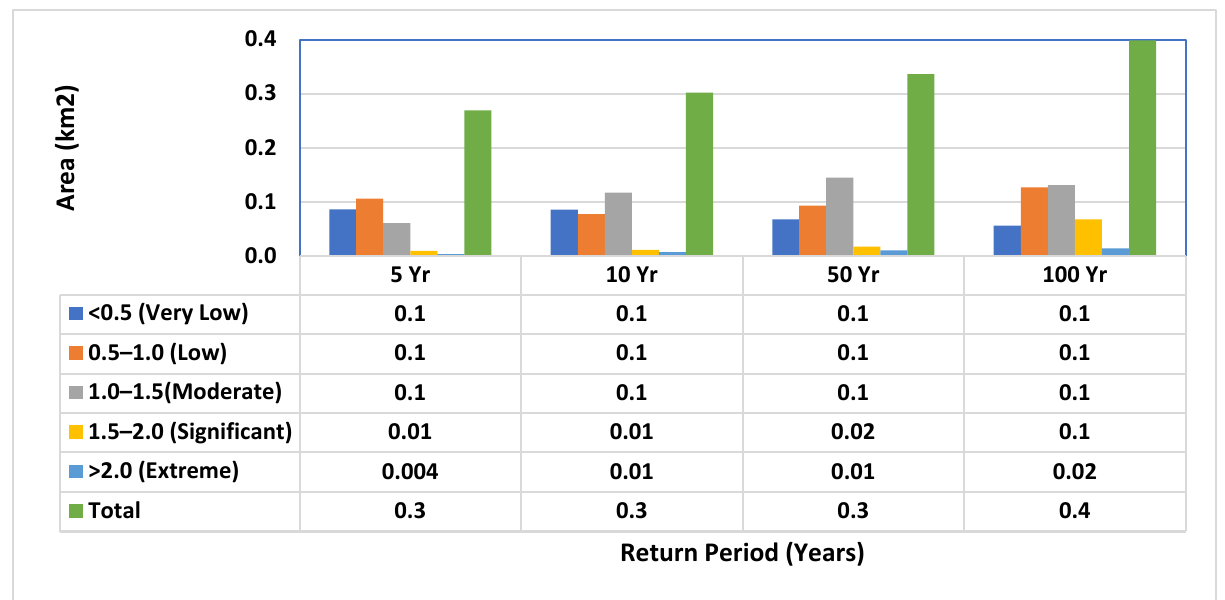
Figure 11. Risk Classification of Settlement Land Cover Type. Similarly, Subsistence farming area under a very low hazard class (<0.5 m) is 22.2, 22.6, 18.9, and 11.9 km 2 for return periods of 5–100 years (Figure 12). It also shows that there is a gradual increase in the low, moderate, and extreme hazard classes.